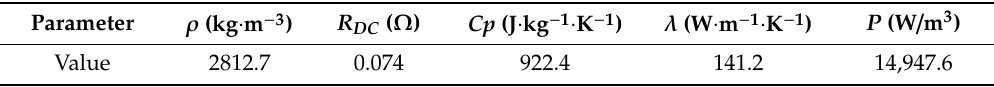
Table 1. The thermodynamic parameters of the